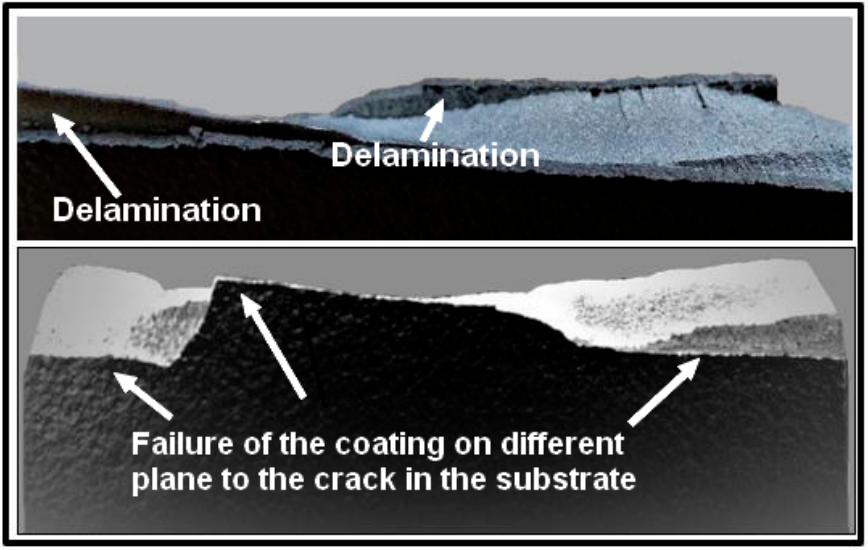
Figure 9. Delamination of specimen S40, which had a 0.5 mm thick 7075 coating, was tested at 25 kN which corresponds to a stress of 187.5 MPa, and failed at approximately 124,000 cycles. Note how the failure of the coating is on a different plane to that of the crack in the 2024-T3.